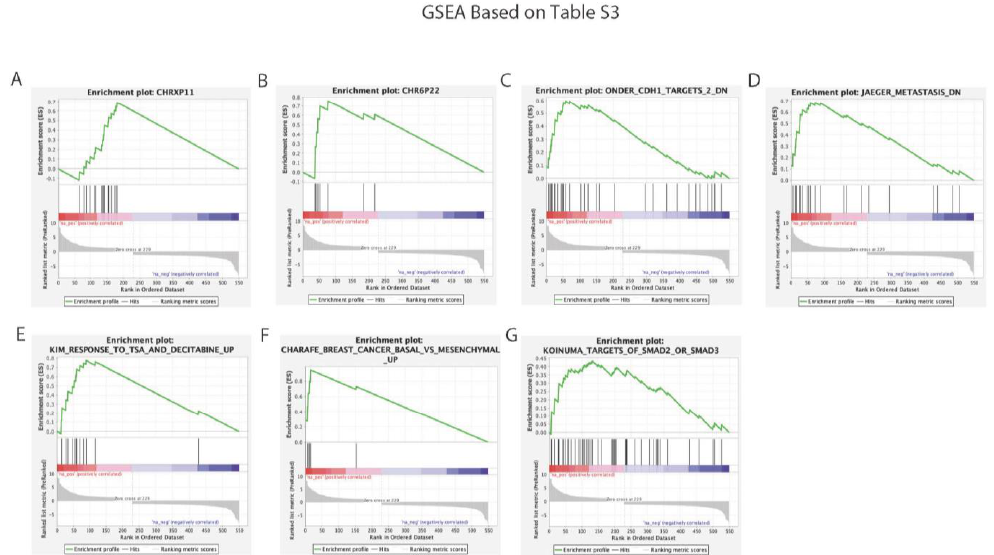
Figure 5. Enrichment plots from the gene set enrichment analysis. ( A – F ) are enrichment plots based